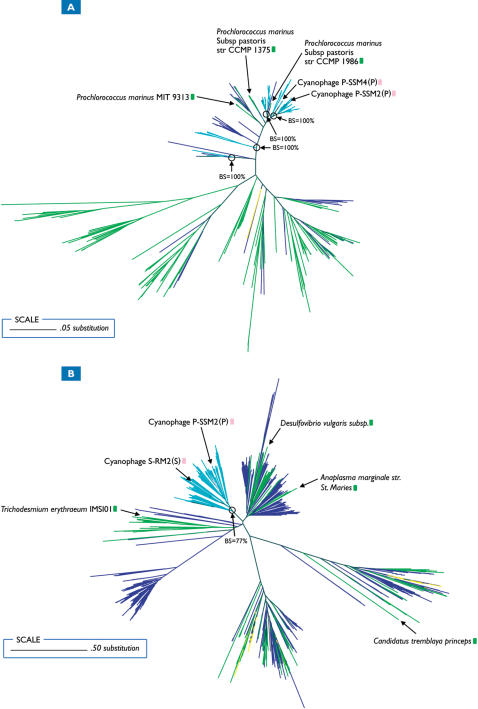
Phylogenetic trees of all GOS and publicly available pstS (A) and talC (B) sequences.BS indicates bootstrap values. GOS and public viral sequences are colored aqua and pink respectively. GOS and public prokaryotic sequences are navy blue and lime green respectively. GOS eukaryotic sequences are colored yellow.